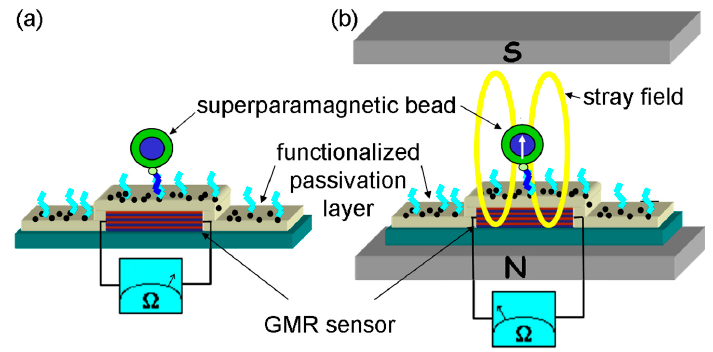
Figure 10. Schematic representation of a magnetic biosensor: ( a ) a superparamagnetic bead functionalized with a receptor molecule hybridize to the target molecule attached onto the sensor surface; ( b ) An external field align the magnetic moment of the bead and the magnetic stray field can be detected by the GMR sensor (adapted from [62]).